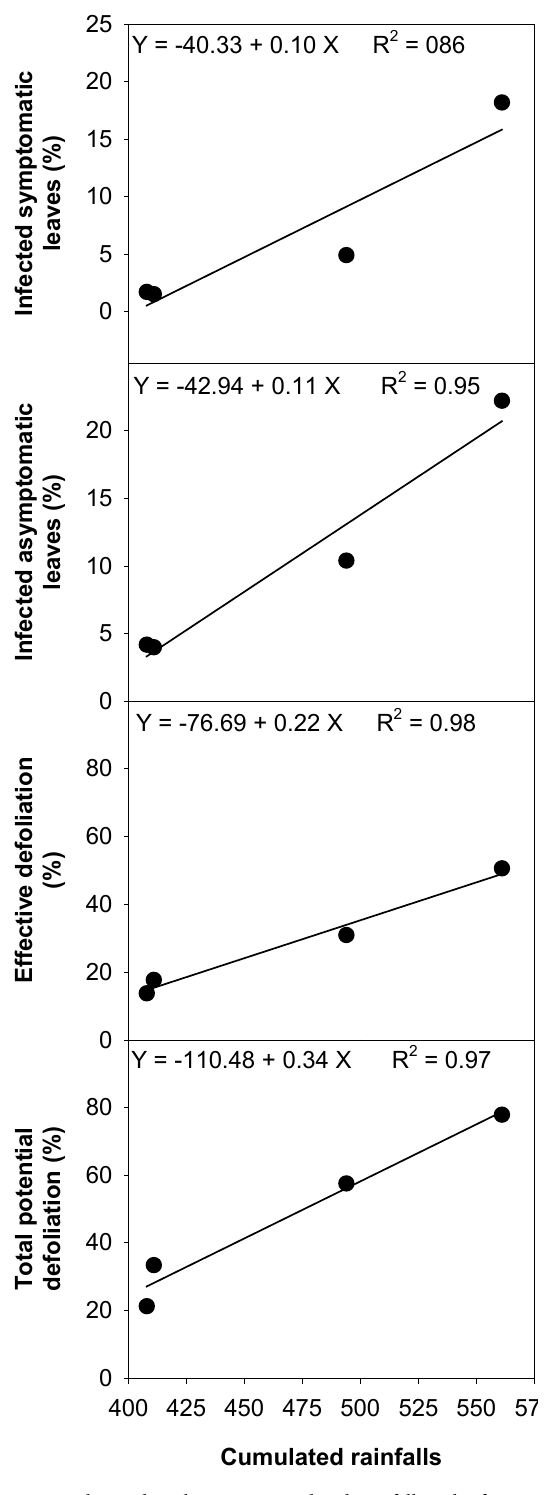
Figure 7. Relationships between cumulated rainfall in the four areas of Palestine (Asira, Burqin, Qabatia and Sir) and infections/defolia- tions caused by peacock eye of